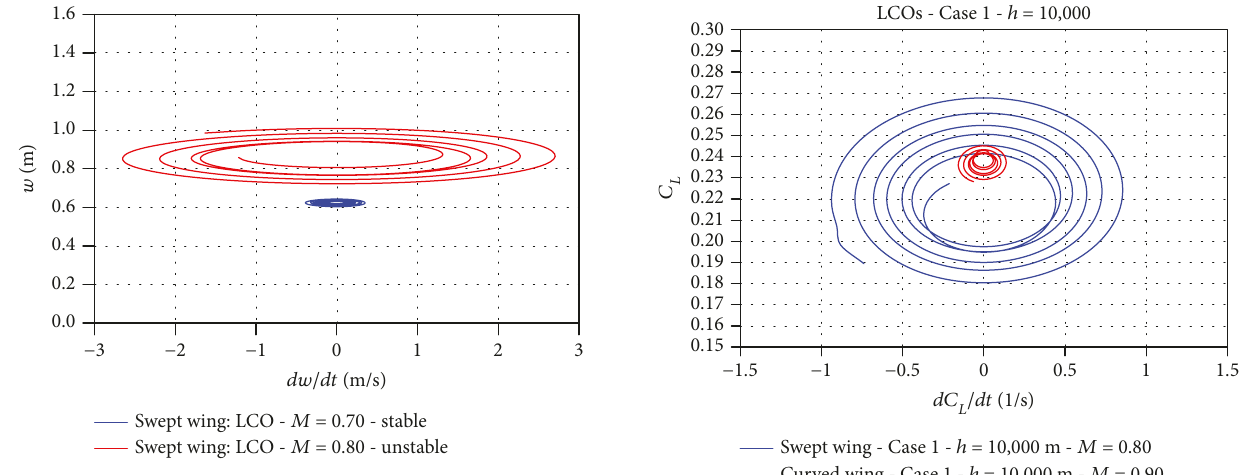
Figure 22: FSI DB — estimation of swept-wing tip displacement LCOs (Case 1 — cruise [20]).